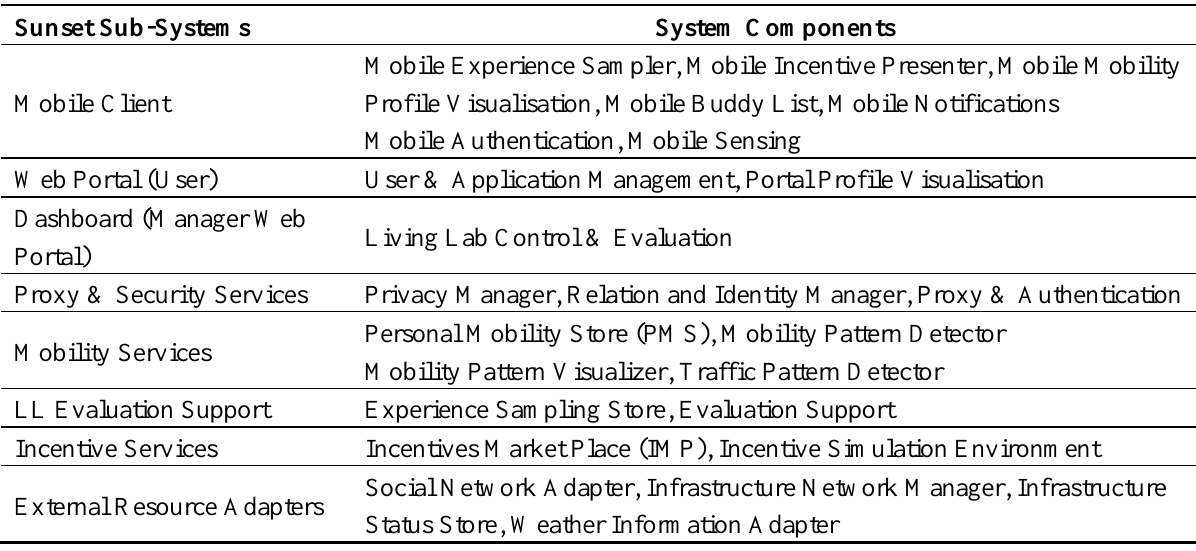
Table 3. Classification of the main SUNSET system